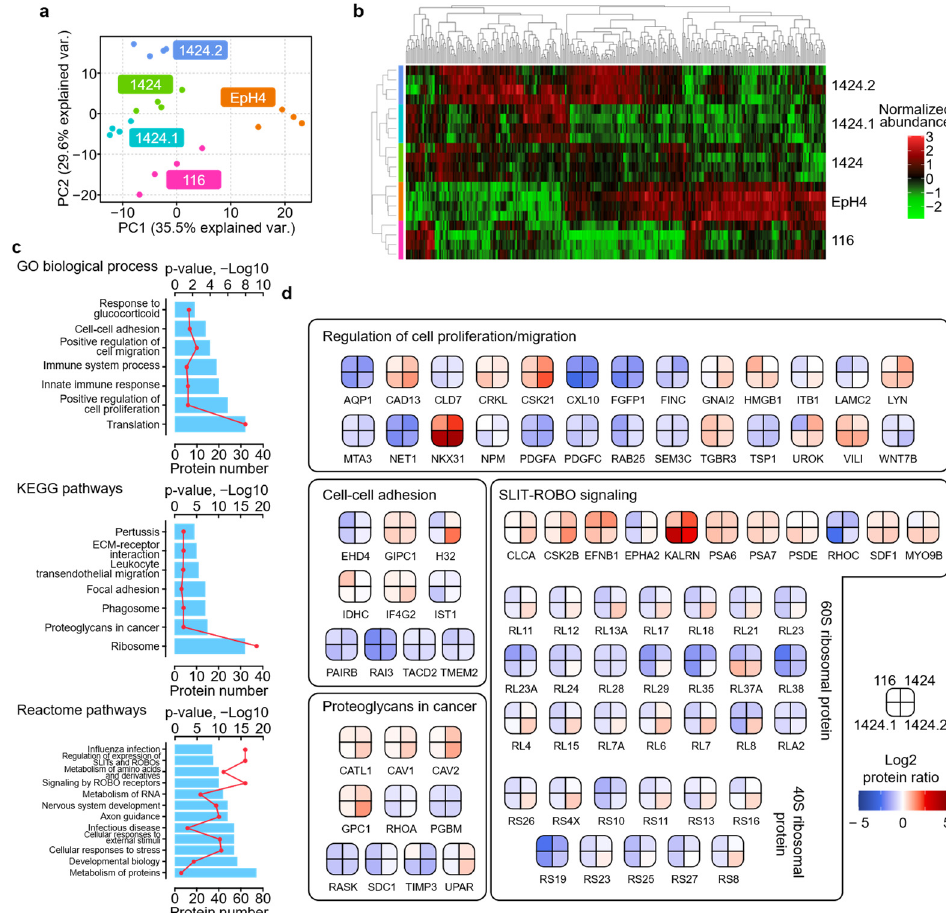
Figure 3. Analysis of proteins with significantly different abundances between the five cell lines. ( a ) Principal component analysis (PCA) of 348 altered proteins; ( b ) heatmap of altered proteins with unsupervised hierarchical clustering; ( c ) GO BP, KEGG, and Reactome pathway terms for which altered proteins were enriched; ( d ) altered proteins enriched in GO BP terms and KEGG/Reactome pathways relevant to cell migration and metastasis.